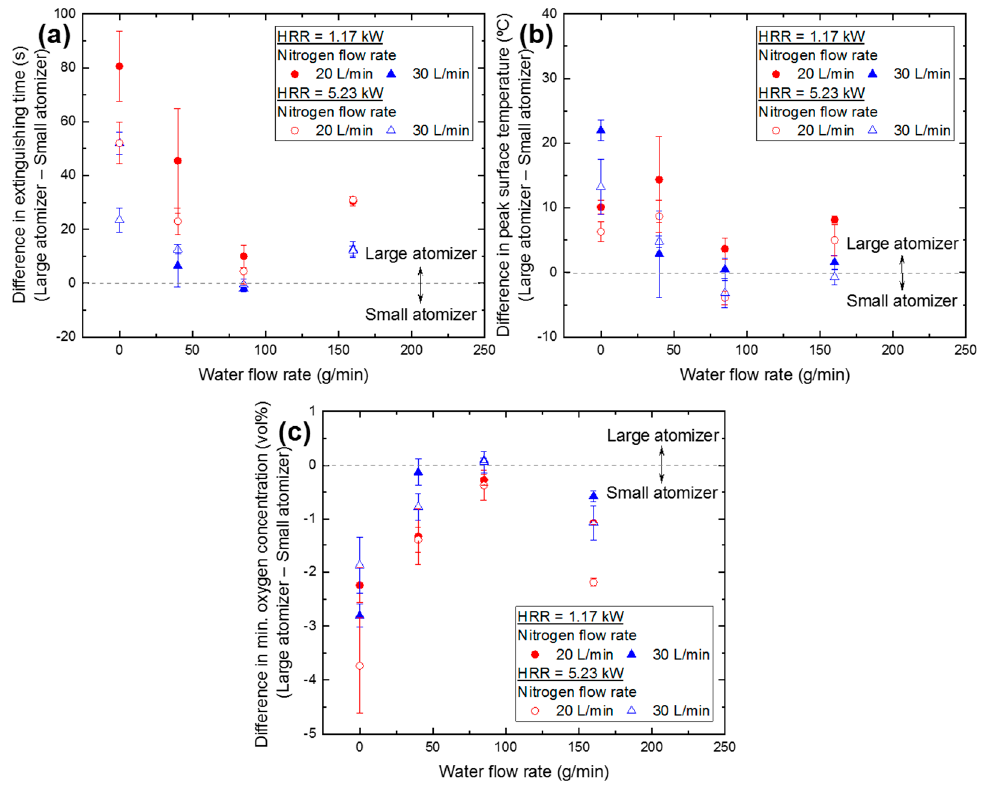
Figure 9. Comparison of differences in measurement parameters between large and small atomizers: ( a ) extinguishing time, ( b ) peak surface temperature, and ( c ) minimum oxygen concentration.